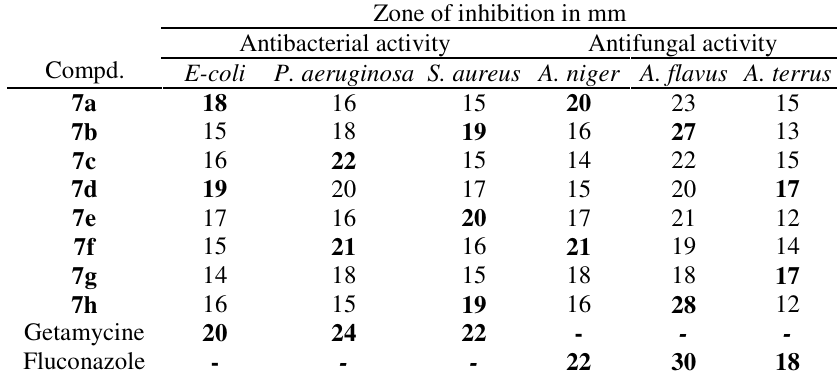
Table 1 . Antimicrobial activity of the title compounds (